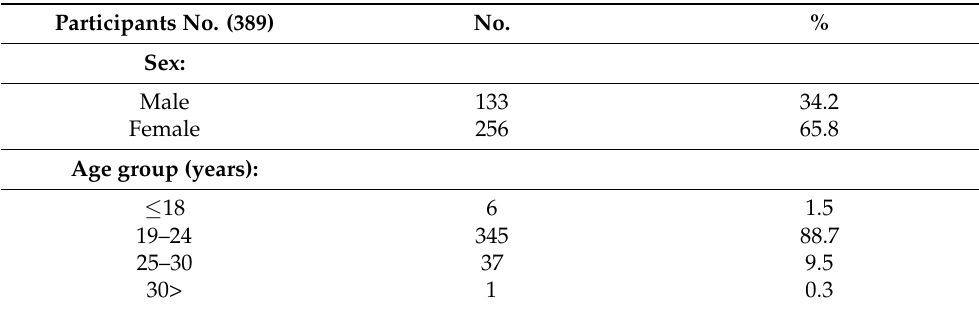
Table 1. Baseline characteristics of the